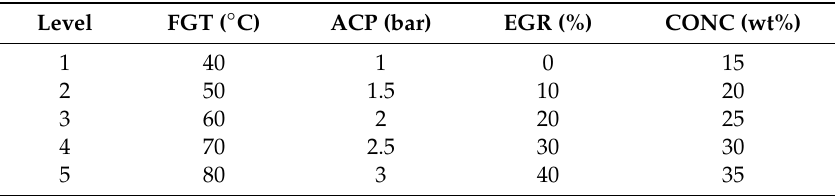
Table 2. Description of factors and levels for the post combustion capture (PCC) plant.